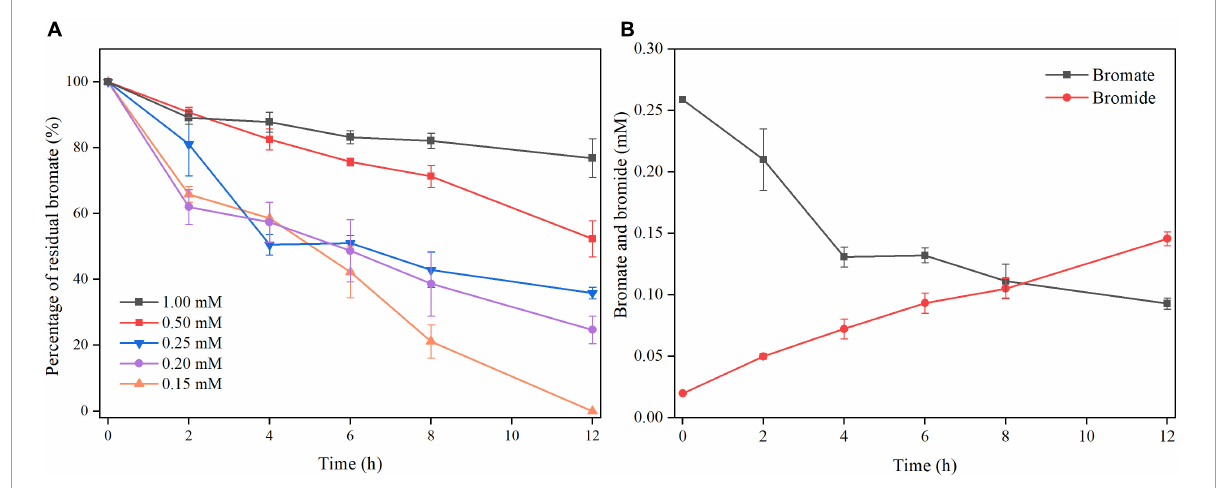
FIGURE1 Microaerobic bromate reduction by S. oneidensis MR-1. (A) The strain was cultured with the dosage of bromate at 0.15, 0.2, 0.25, 0.5, and 1 mM. (B) The strain was cultured with the dosage of bromated at 0.25 mM. Error bars represent standard deviations of triplicate samples.